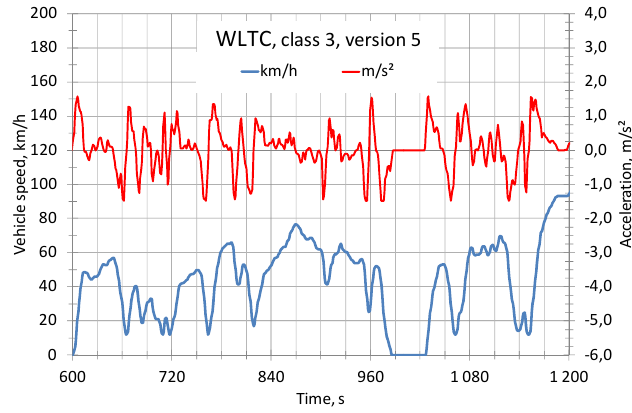
Fig. 2. Speed and acceleration profiles of WLTC.